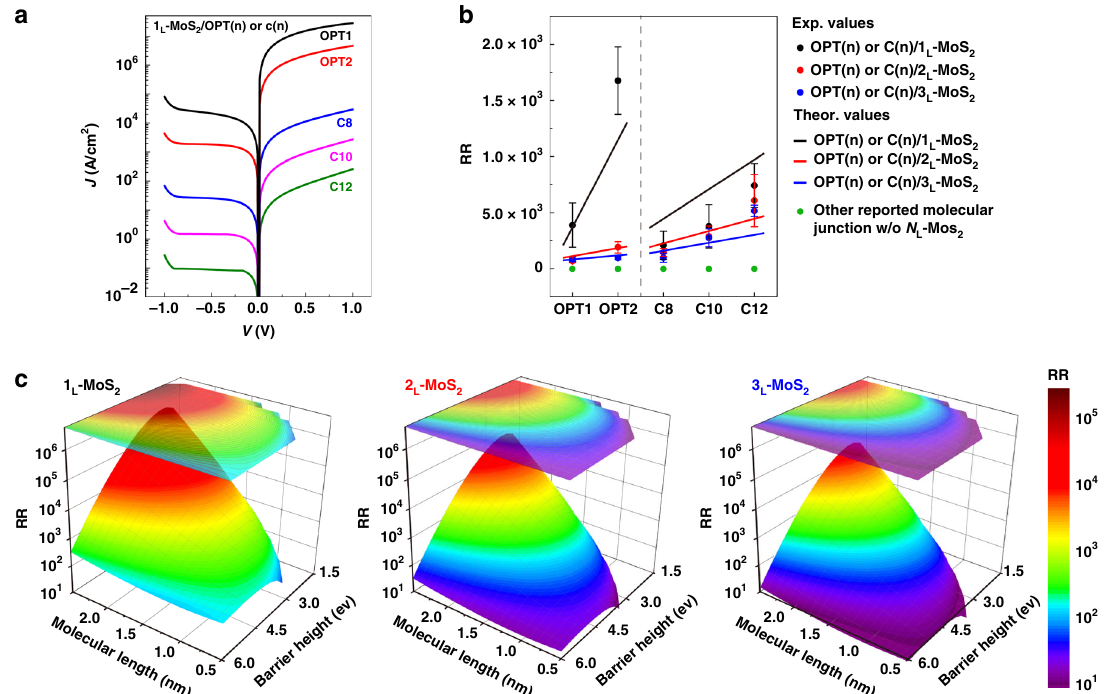
Fig. 4 Generalization of molecular heterojunction recti fi ers. a J - V plots for Au/OPT( n ) ( n = 1 or 2) and C( n ) ( n = 8, 10, or 12)/1 L -MoS 2 /Au junctions calculated from the pathway-dependent charge transport mechanism (Eqs. (1) – (3) and Supplementary Fig. 11). b RR plots as a function of the molecular species. The solid lines were calculated from the pathway-dependent charge transport mechanism. The green solid circles are the RR values obtained from other reported molecular junctions consisting of simple σ - or π - bonded molecules without MoS 2 (RR = ~1). The error bars indicate the standard deviations of RR obtained from at least 100 different positions of each junction. c Contour plots of estimated RR as a function of the molecular length and barrier height for the molecular heterojunction with different numbers of MoS 2 layers ( N L = 1 L , 2 L , and 3 L Methods Sample preparation and characterization . All 2D semiconductors (1 L -/2 L -/3 L - MoS 2 and 1 L -WSe 2 ) are prepared by using the typical mechanical exfoliation and transfer method. The exfoliated MoS 2 and WSe 2 layers are picked up by using a poly-propylene carbonate (PPC)/polydimethyl siloxane (PDMS) stamp and then mechanically transferred onto the Au/SiO 2 /Si substrate. The number of TMD